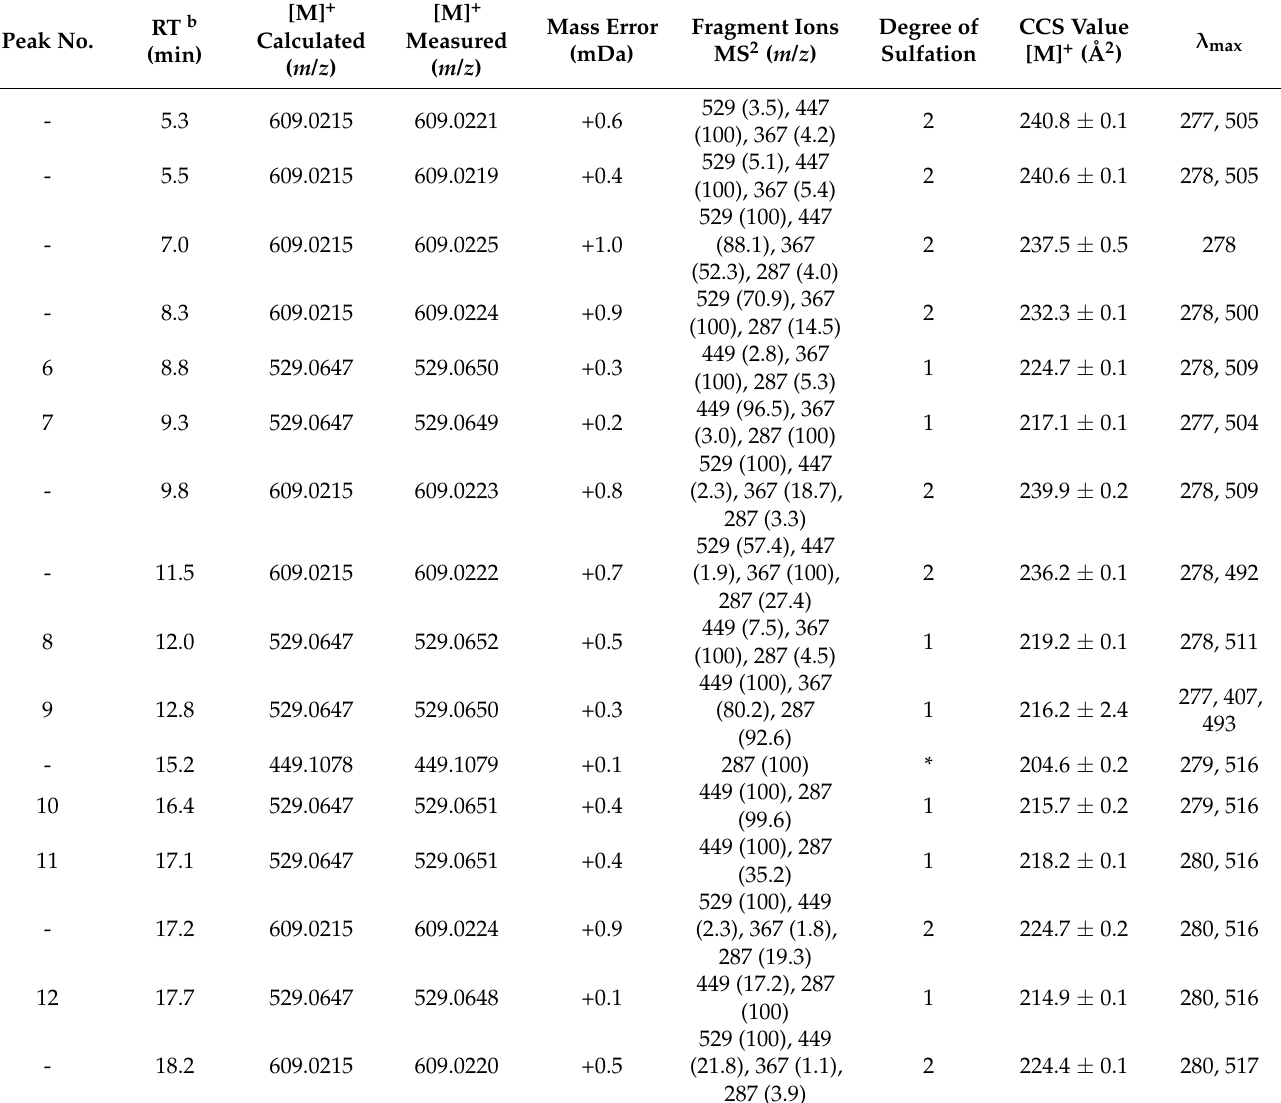
Table 2. LC-DAD-ESI-LIT and LC-DAD-ESI-IMS-QTOF results of the synthesis reaction of cyanidin-3- O -glucoside sulfates.